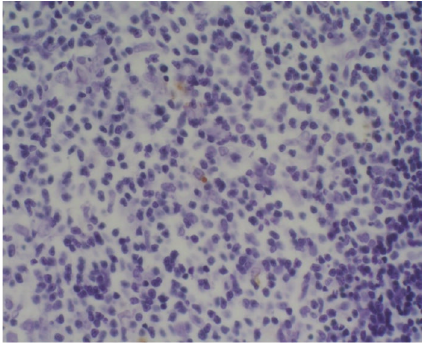
Figure 2: Sham operation group: 6 hours; Tunel × 200.